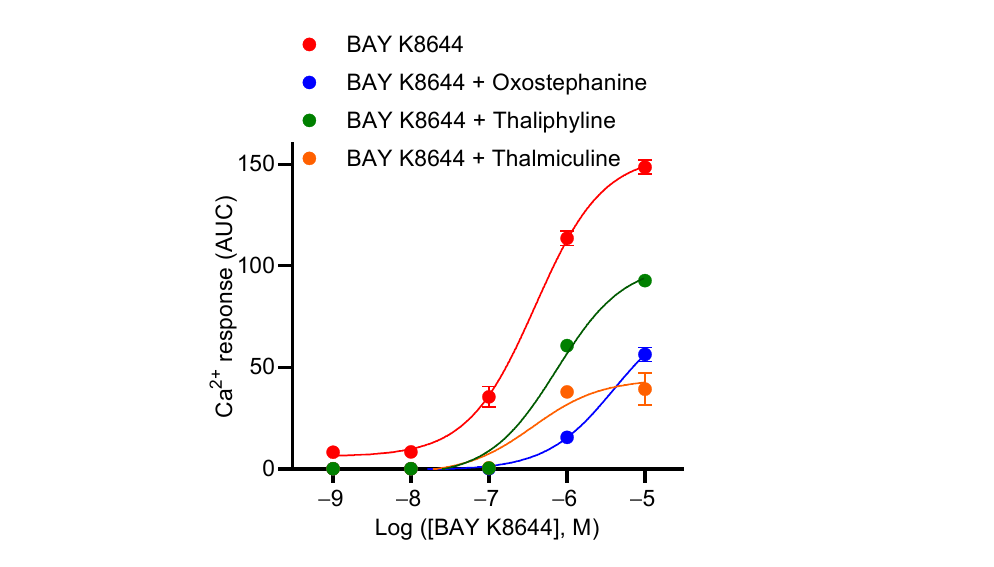
Figure 6. Concentration–response curves of BAY K8644 in the presence of oxostephanine, thalmiculine, or thaliphylline. A total of 10 µM of oxostephanine, thalmiculine, and thaliphylline were coinjected with increasing concentrations of BAY K8644. Data (AUC of Ca 2+ kinetic response) were best fitted with Hill–Langmuir equation and are shown in Table 4. Data are mean ± SEM ( n = 3). These experiments were repeated thrice. Table 4. Effects of oxostephanine, thaliphylline, and thalmiculine on potency and efficacy of BAY K8644.